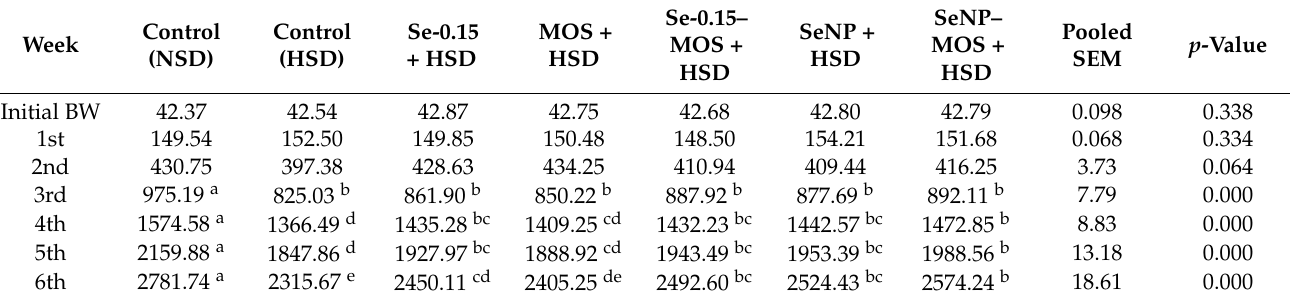
Table 2. Effect of selenium nanoparticles–MOS on body weight (grams) of broiler chickens reared under higher stocking density.